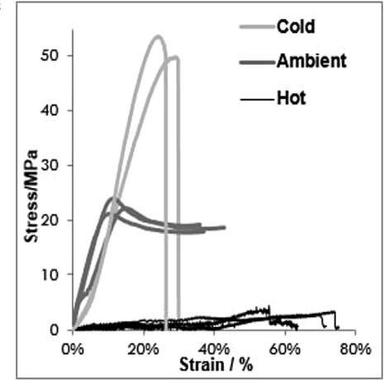
Mechanical response of (a) Tango Black Plus at 300 mm min1 , (b) VeroWhitePlus, (c) Rigid Light Grey at 1 mm min1 at different temperatures.